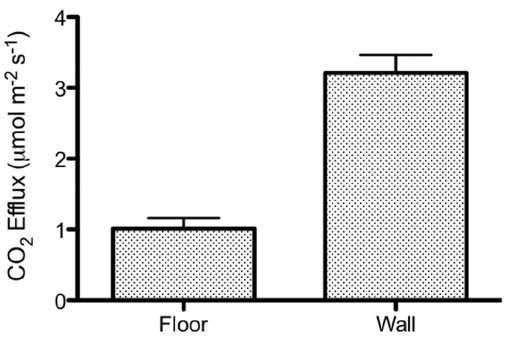
Figure 1. CO 2 efflux from the floors and walls of shrimp ponds in Bali, Indonesia. The rates of CO 2 efflux from the walls were significantly higher than pond floors (F 1,28 =25.66, P , 0.0001).